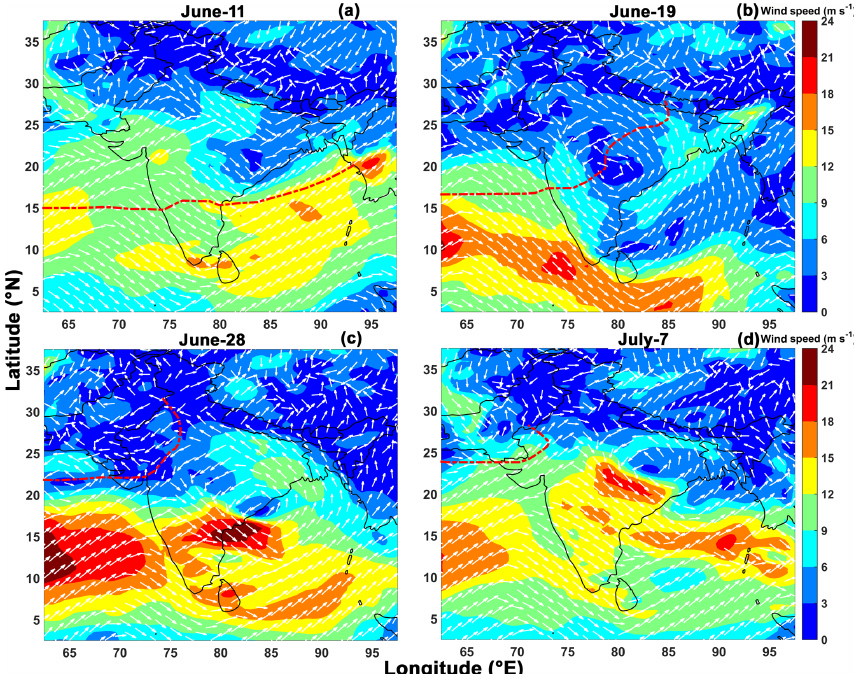
Figure 2. The mean wind field at 850hPa during different days of the campaign period (Dee et al., 2011), with colours representing the magnitude of the wind in ms − 1 . The arrows indicate the direction of the mean wind. The northernmost position of the monsoon trough for the day is shown by the dashed red line on each panel (data source: https://metnet.imd.gov.in/imdnews/ar2016.pdf, last access: 30 January